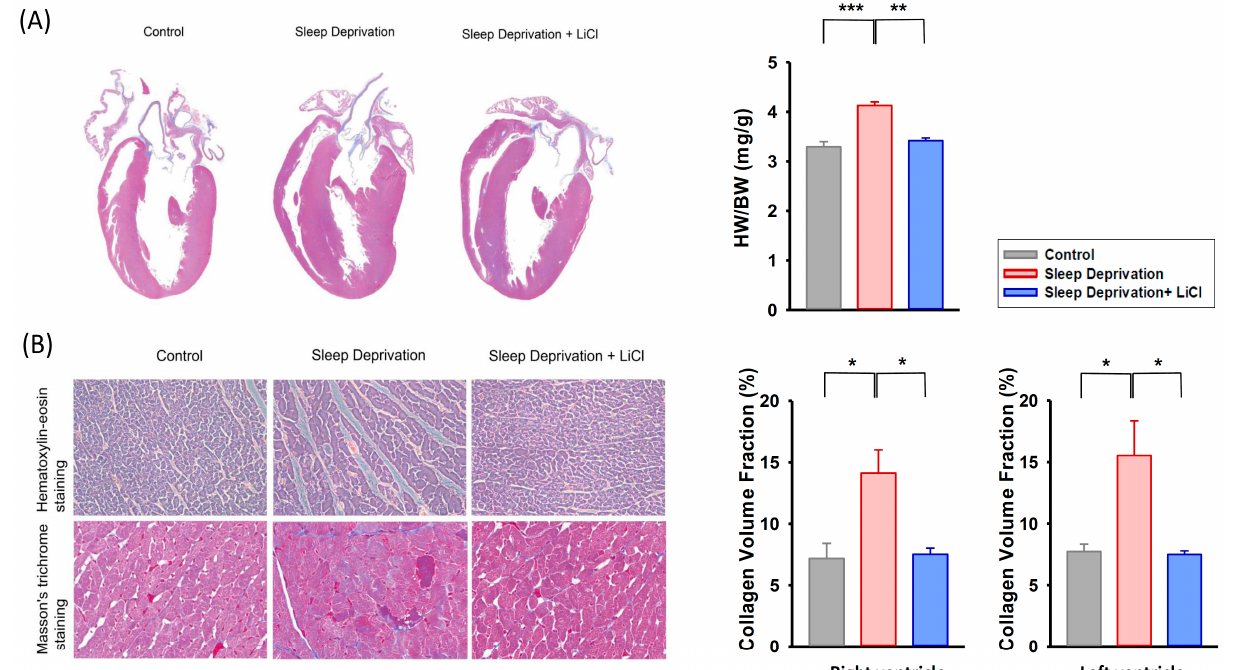
Figure 2. Cardiac morphology, histology, and fibrotic severity in REM sleep deprivation with and without lithium treatment. ( A ) Gross examination of a heart and its four-chamber view histology stained with Masson’s trichrome staining. The four-chamber view histology revealed that the REM sleep-deprived rats exhibited greater ventricular hypertrophy than did the control and lithium-treated REM sleep-deprived rats. The heart-to-body weight ratios were higher in the REM sleep-deprived rats ( n = 3) than in the control ( n = 3) and lithium-treated REM sleep-deprived ( n = 3) rats. ( B ) The upper and lower panels show hematoxylin–eosin staining (original magnification, ×200) and Masson’s trichrome staining (original magnification, ×400) over the ventricles, respectively. The REM sleep-deprived rats ( n = 3) exhibited a greater increase in fibrosis compared with the control ( n = 3) and lithium-treated REM sleep-deprived ( n = 3) rats. Fibrosis severity levels are expressed as collagen volume fractions. * p < 0.05; ** p < 0.01; *** p < 0.001.